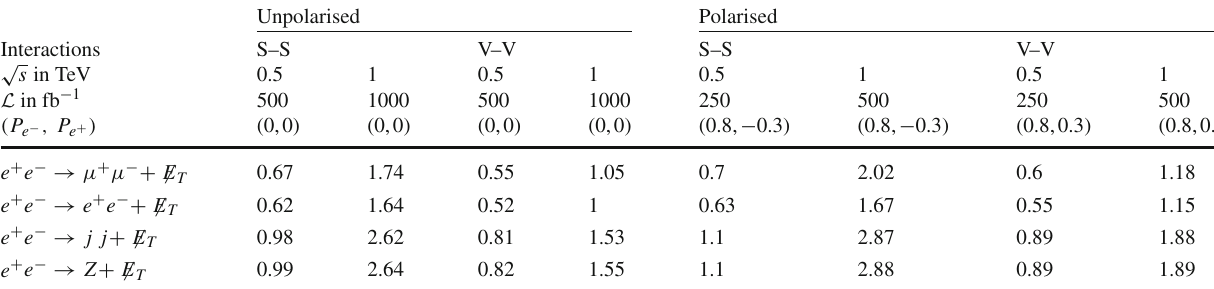
= 1 ab − 1 respectively, through all visible channels of e + e − → Z + χ ¯ χ . √ s The respective coupling of DM with the charged lepton α l to be unity